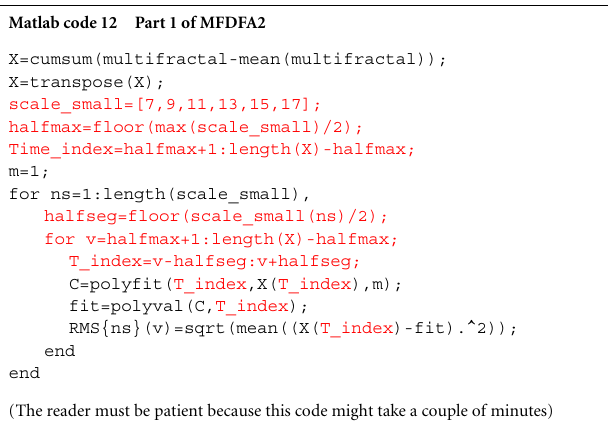
FIGURE 9 | Multiple representations of multifractal spectrum for multifractal ( blue traces ), monofractal ( red traces ), and whitenoise ( turquoise trace ) time series. (A) q -order Hurst exponent Hq computed in Matlab code 9. (B) Mass exponent tq computed in Matlab code 10. (C) Multifractal spectrum of Dq and hq ( upper right panels ) computed in